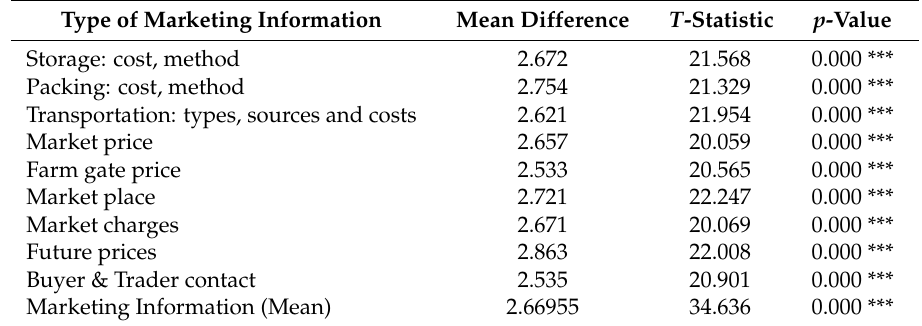
Table 7. Results of student’s t -test of the differences in access to different types of marketing